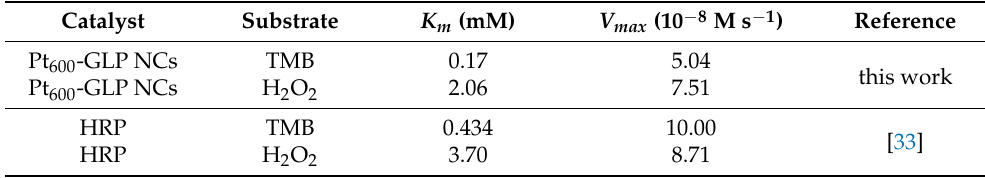
Table 1. Comparison of the kinetic parameters of Pt 600 -GLP NCs and HRP.